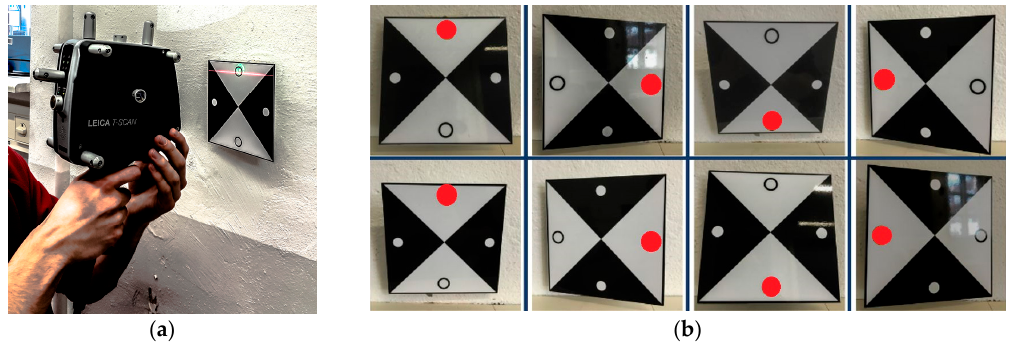
Figure 7. ( a ) Scan of each target with Leica T-Scan 5 for the determination of the target centre and ( b ) the eight scan positions.